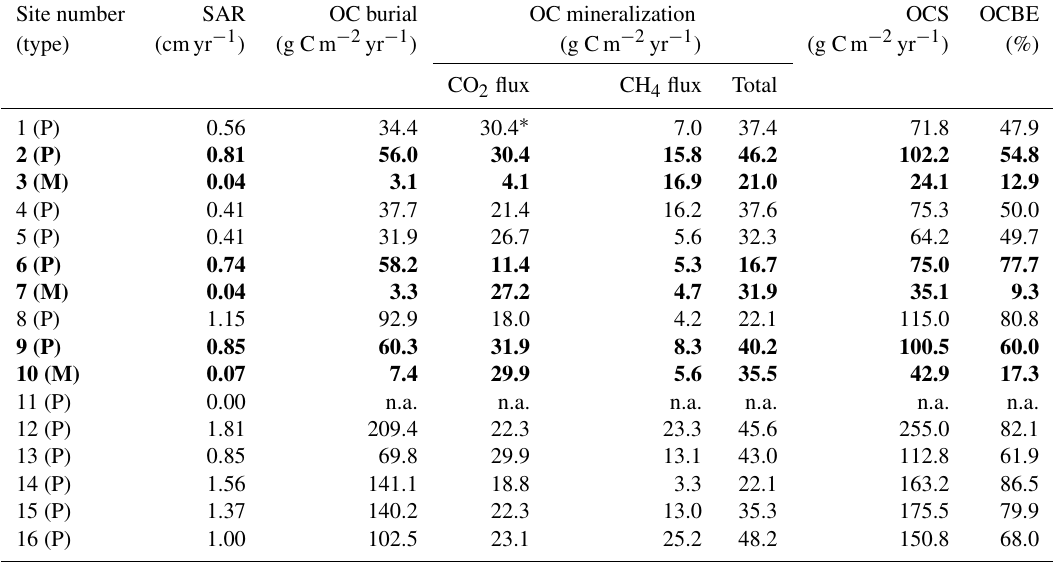
Table 1. Sediment accumulation rate (SAR), OC burial, OC mineralization, OC gross sedimentation (OCS) and OC burial efficiency (OCBE) at each of the sampling sites in Mascarenhas de Moraes. Sites close to the margin (M) and in the pelagic zone (P) in the same transects perpendicular to the rivers–dam transect are boldfaced. Numbering started at the dam (i.e., site 16 is furthest away from the dam; see Fig. 1).